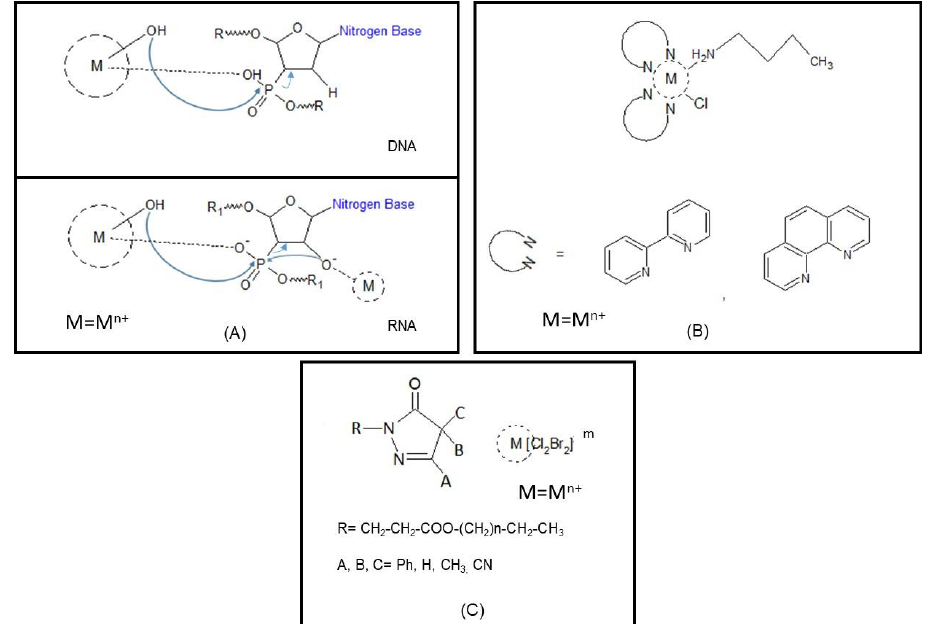
Figure 1. Schematic representation of DNA / RNA cleavage catalyzed by metal complexes; arrows indicate the nucleophilic attack and leaving groups during substitution, M n + = mostly divalent cations ( A ) assisted by metallosurfactants with bidentate N,N ligands ( B ), and ( C ) with di ff erent substituents, M n + = mostly in octahedral and tetrahedral coordination geometry, m = the net charge of the complex, including surfactant